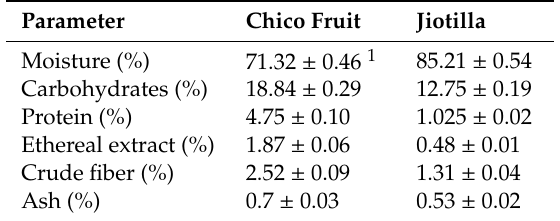
Table 2. General proximate analysis of the collected plant samples.